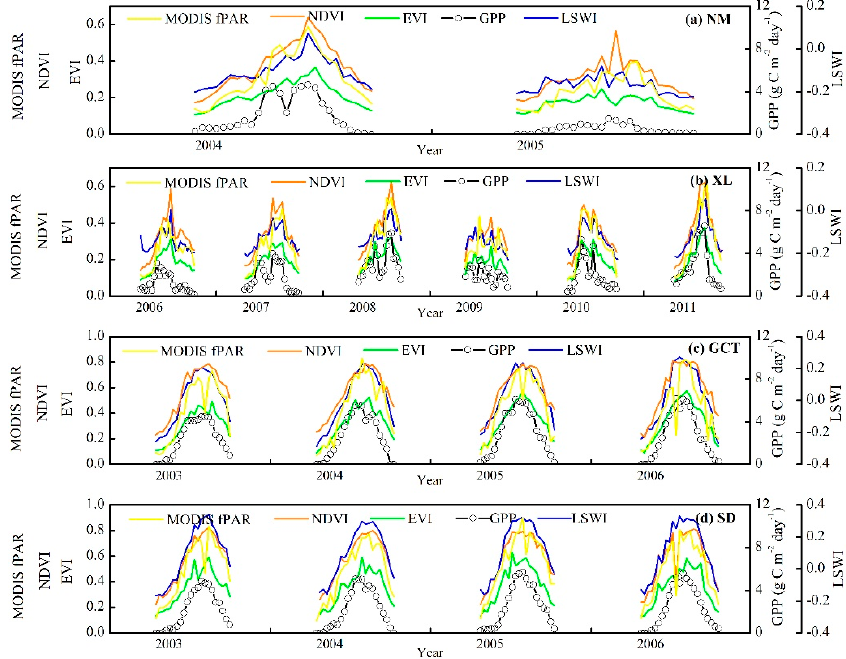
Figure 5. Seasonal and interannual variations in the observed gross primary production (GPP_tower), fraction of the absorbed photosynthetically active radiation (fPAR), normalized difference vegetation index